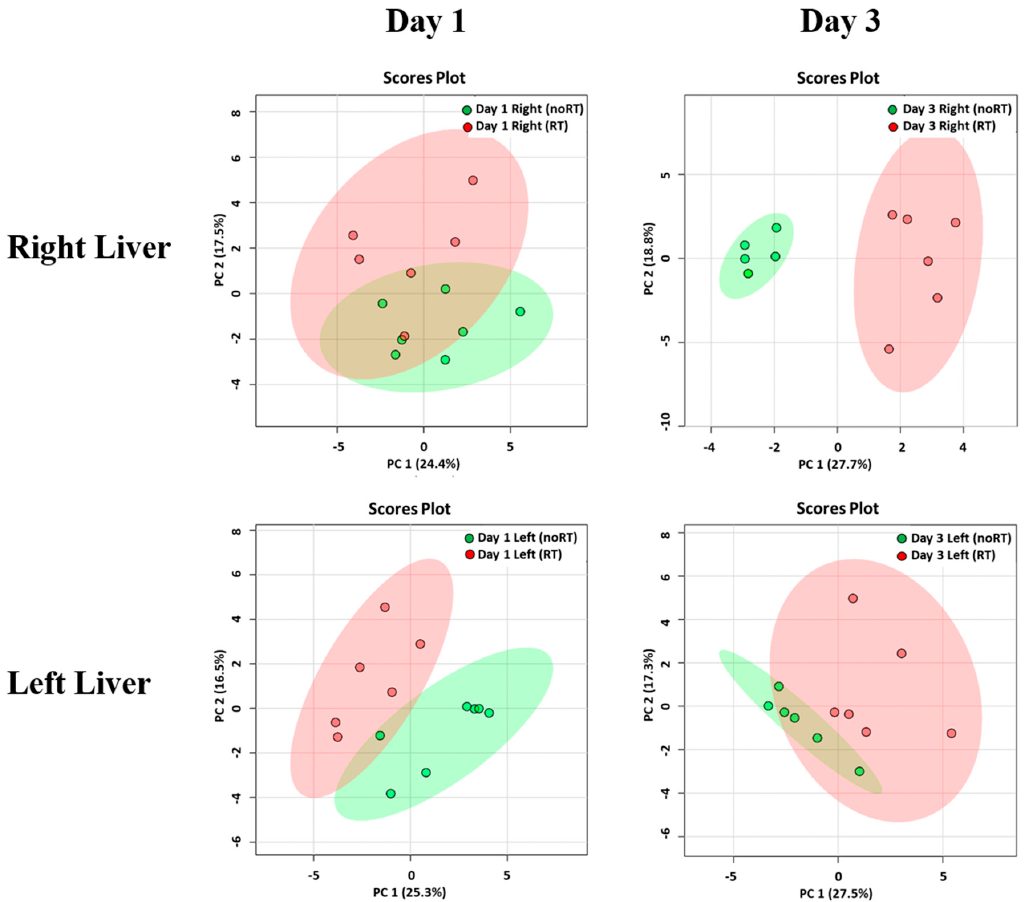
Figure 2. Principal component analysis of metabolite distribution in the RT ( n = 6) and no-RT ( n = 6) groups on the first and third post-irradiation days. Results are reported separately for the right and left lobes of the liver using partial least squares discriminant analysis. The areas (red for the RT group and green for the no-RT group) comprised within the elliptical rings indicate a 95% confidence level. A clear discrimination between the two experimental groups was observed for the right liver on the third post-irradiation day. Table 1. Dynamic changes in the expression of different metabolites in the right and left lobes of the liver observed in the two study groups on the first and third post-irradiation days.